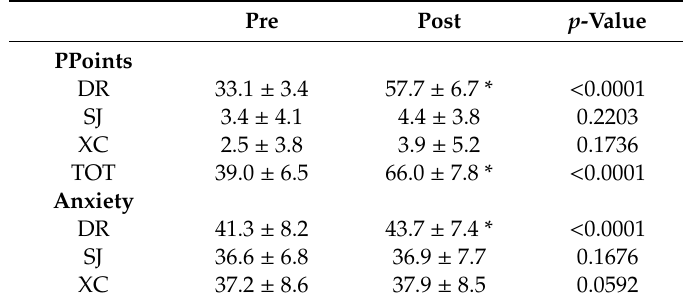
Table 1. For Dressage (DR), Show-jumping (SJ) and Cross-country (XC) competition performance (PPoints), anxiety, rating of perceived exertion (RPE), test duration (Time) and session RPE (sRPE) values are reported as mean ± standard deviation, p -values are reported for di ff erences between pre and post lockdown